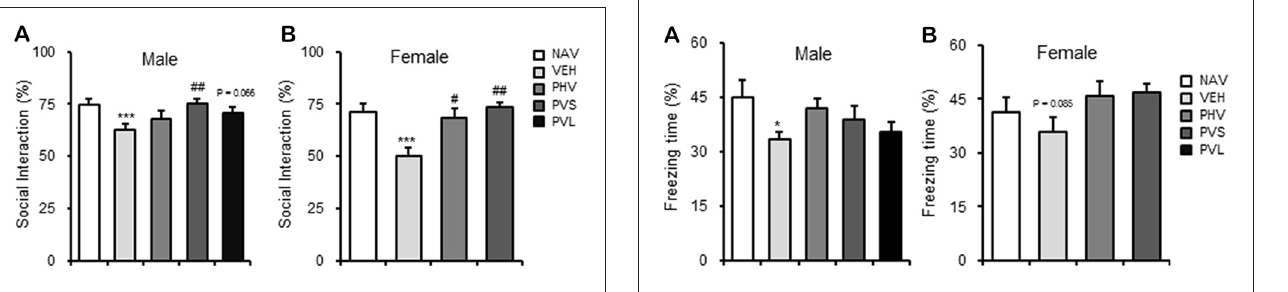
FIGURE 4 | HRW administration rescued the impaired social behavior in VPA-exposed mice offspring. HRW administration significantly reversed the maternal VPA exposure-induced decrease of the SI index of both male (A) and female (B) mice offspring in the SIT. ∗∗∗ P < 0.005 compared with the saline-injected group (NAV); # P < 0.05, ## P < 0.01 compared with the VPA-exposed group ( n = 6–10 per group).